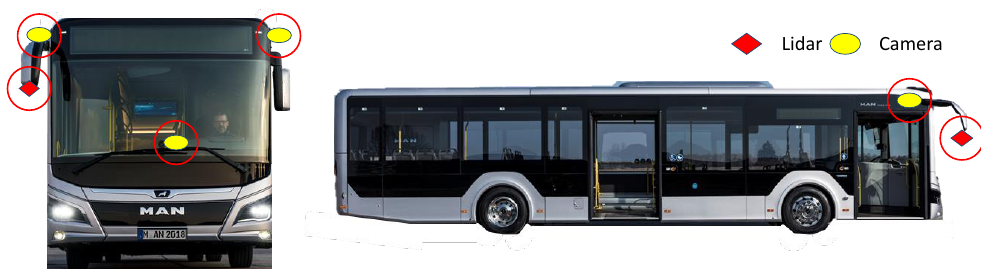
Figure 6. Test vehicle: a MAN Lion’s City 12 bus with positions for LiDAR and camera sensors.